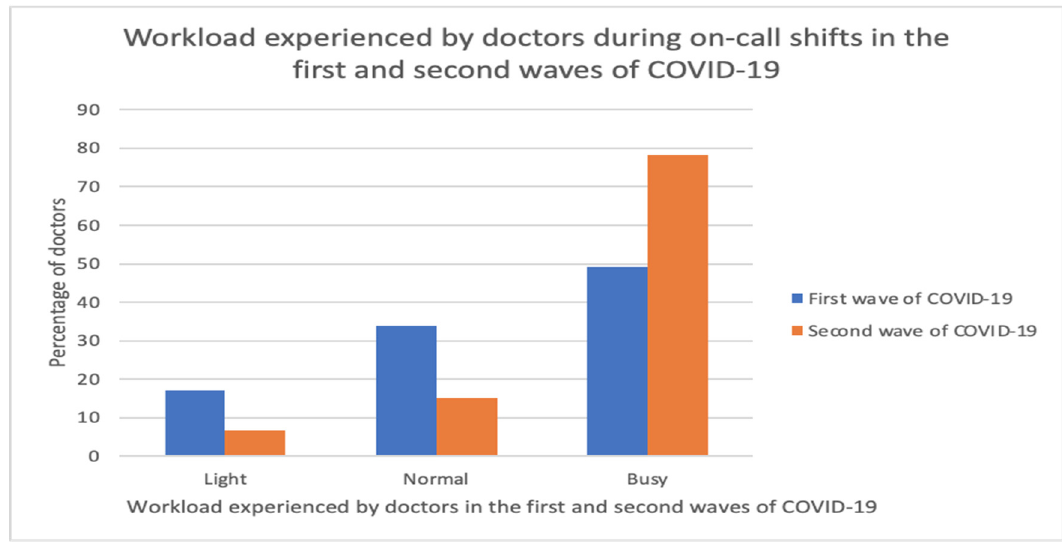
Figure 2. Workload experienced by doctors during their on-call shifts in the first and second waves of COVID-19. Table 3. COVID-19 working experience of the survey participants.